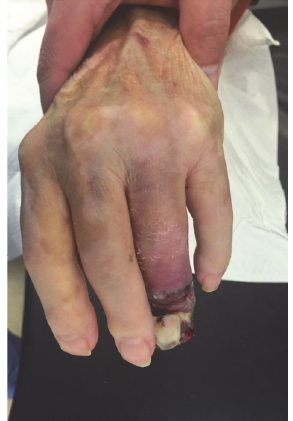
Figure 3: ADPA lesion after biopsy, dorsal